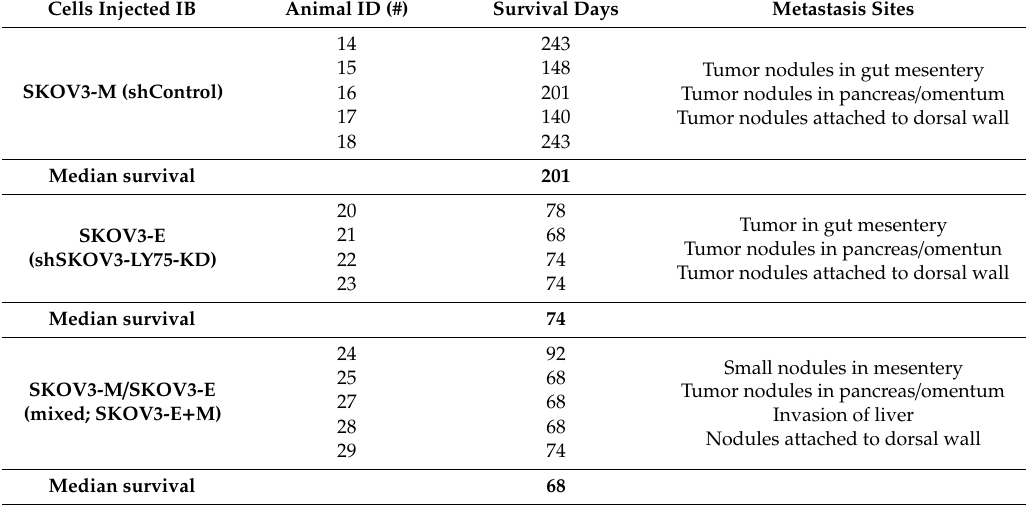
Table1. Survivaltimeofmiceincludedinphase1experimentalgroups, andsitesofmetastasisformation. Cells Injected